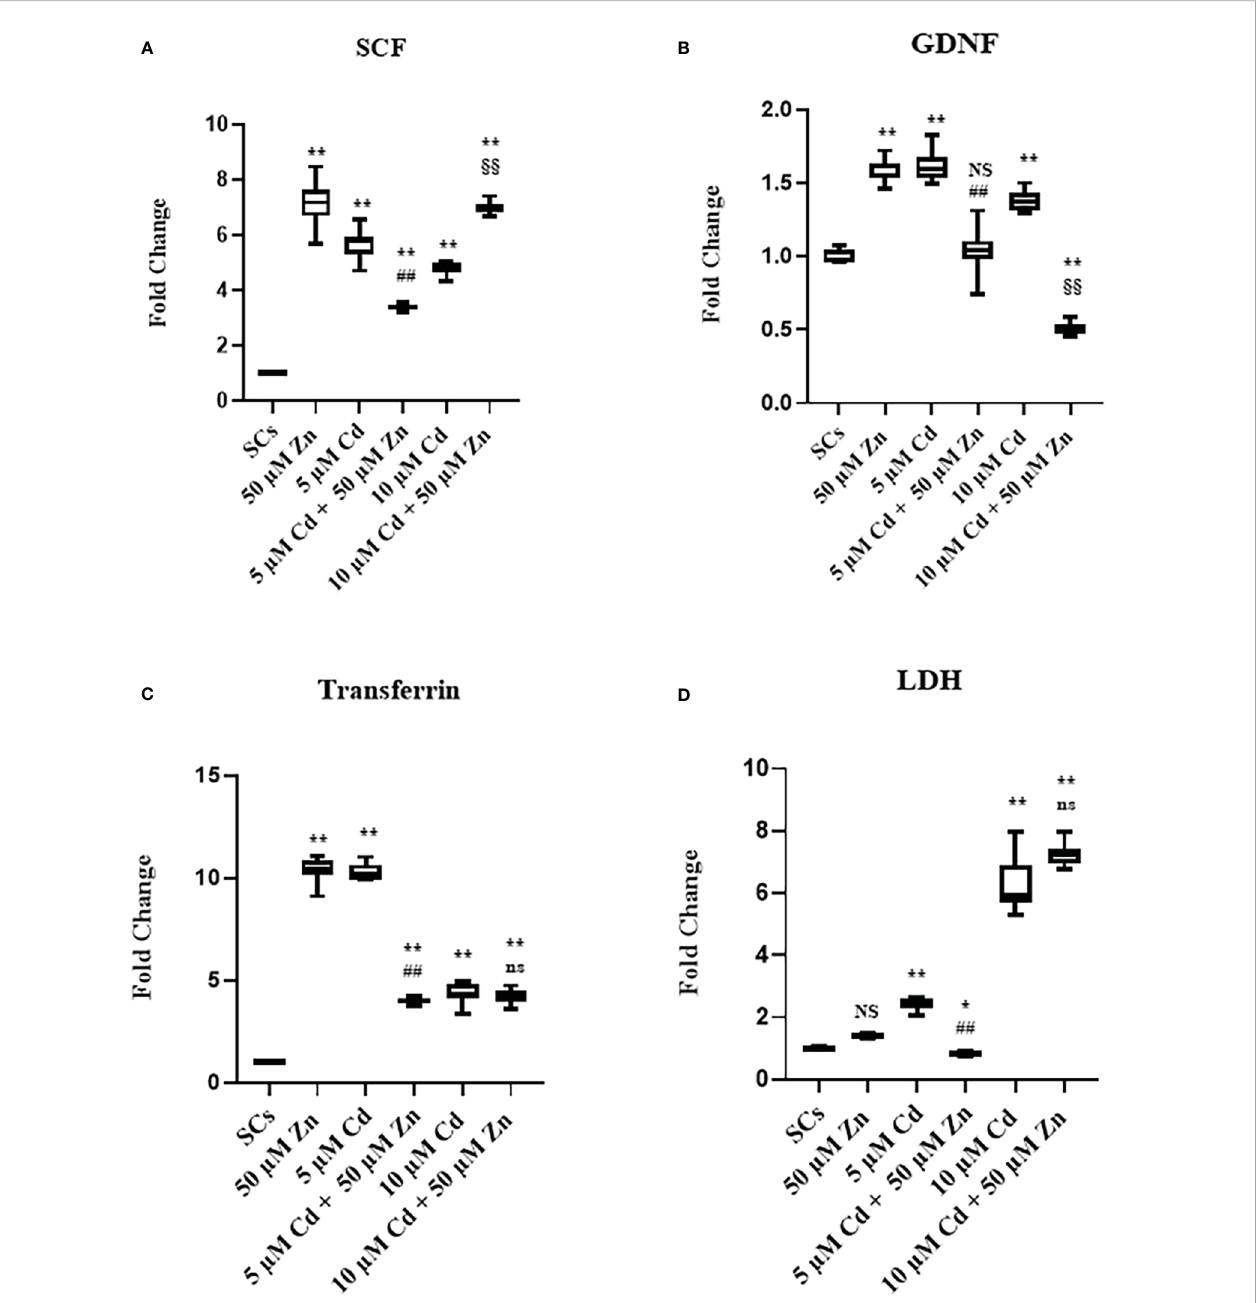
FIGURE 6 Real-time PCR analysis of SC functionality. Gene expression of SCF (A) GDNF (B) , transferrin (C) , and lactate dehydrogenase (LDH) (D) in the absence (unexposed-control group, SCs) or presence of 5 or 10 µM CdCl2 and/or 50 µM ZnCl2 for 48 h. Data presented as the mean ± SEM. (Not signi fi cant, NS). NS vs. SCs, *p < 0.05 and **p < 0.001, #p < 0.05 and ##p < 0.001 vs. 5 µM Cd, §p < 0.05 and §§ p < 0.001 vs. 10 m M. (Not signi fi cant, ns) ns vs. 10 m M of three independent experiments, each performed in